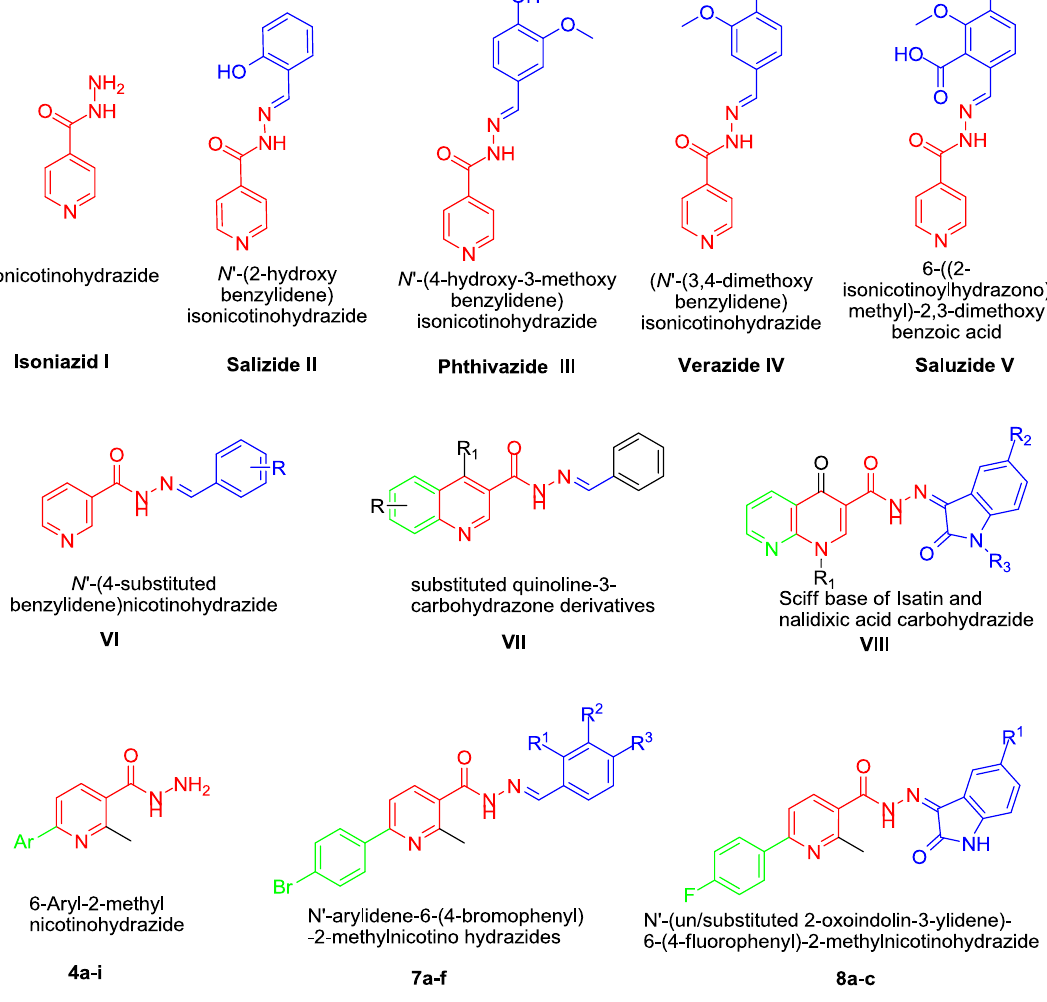
Figure 1. Structures of antitubercular drugs I – VIII and the target derivatives 4a – i , 7a – f and 8a – c